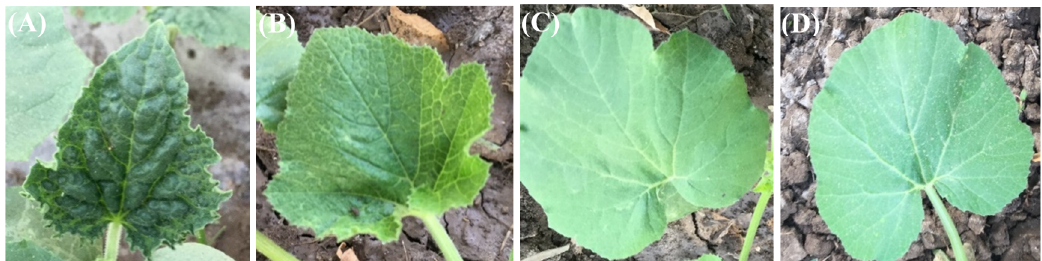
Figure 1. Cucumber mosaic cucumovirus (CMV) symptoms in untreated cucumber (challenge control) ( A ) and cucumber foliar-sprayed with glycine betaine (GB) ( B ), chitosan (CHT) ( C ) and GB+CHT ( D ) at 21 days after inoculation.